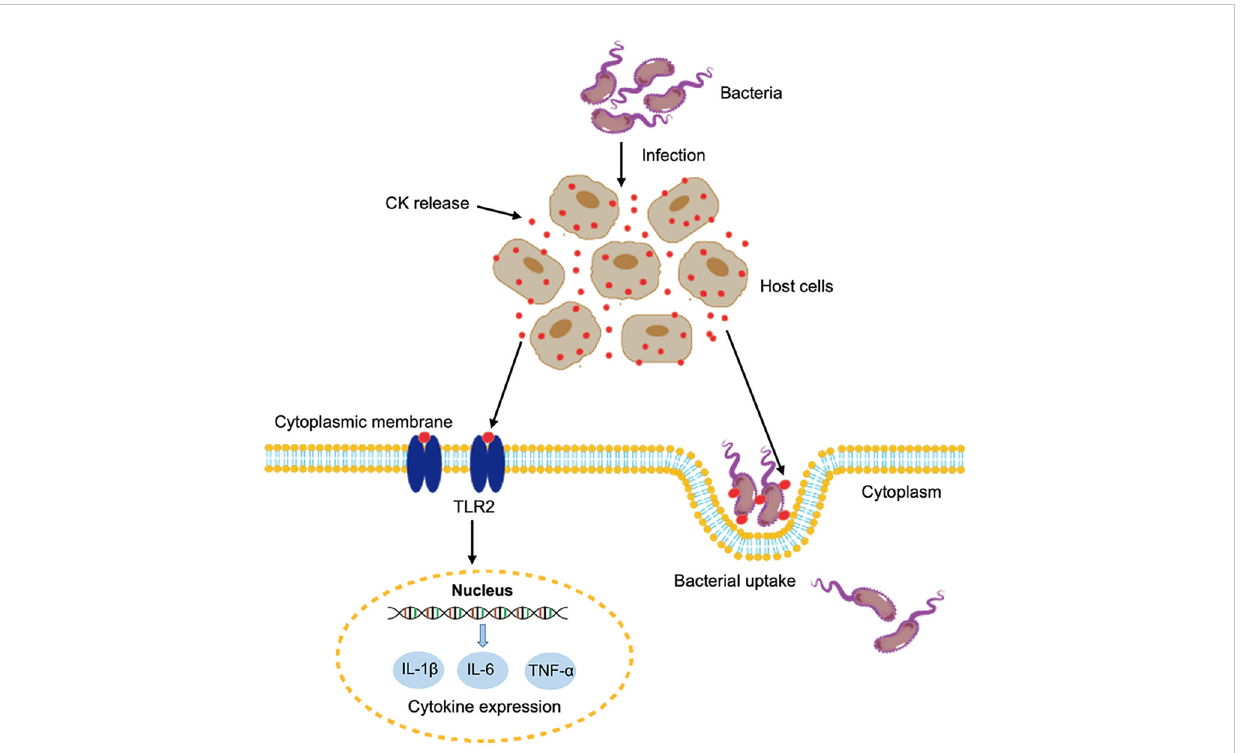
FIGURE 6 A proposed model of the immune function of CsCKM-1/2. Bacterial infection induces the release of CsCKM-1/2. CsCKM-1/2 interact with TLR2 and activate TLR2-mediated signaling, which induces cytokine expression and likely inhibits bacterial infection. In addition, CsCKM-1/2 bind to the bacterial pathogen and enhance bacterial uptake by host